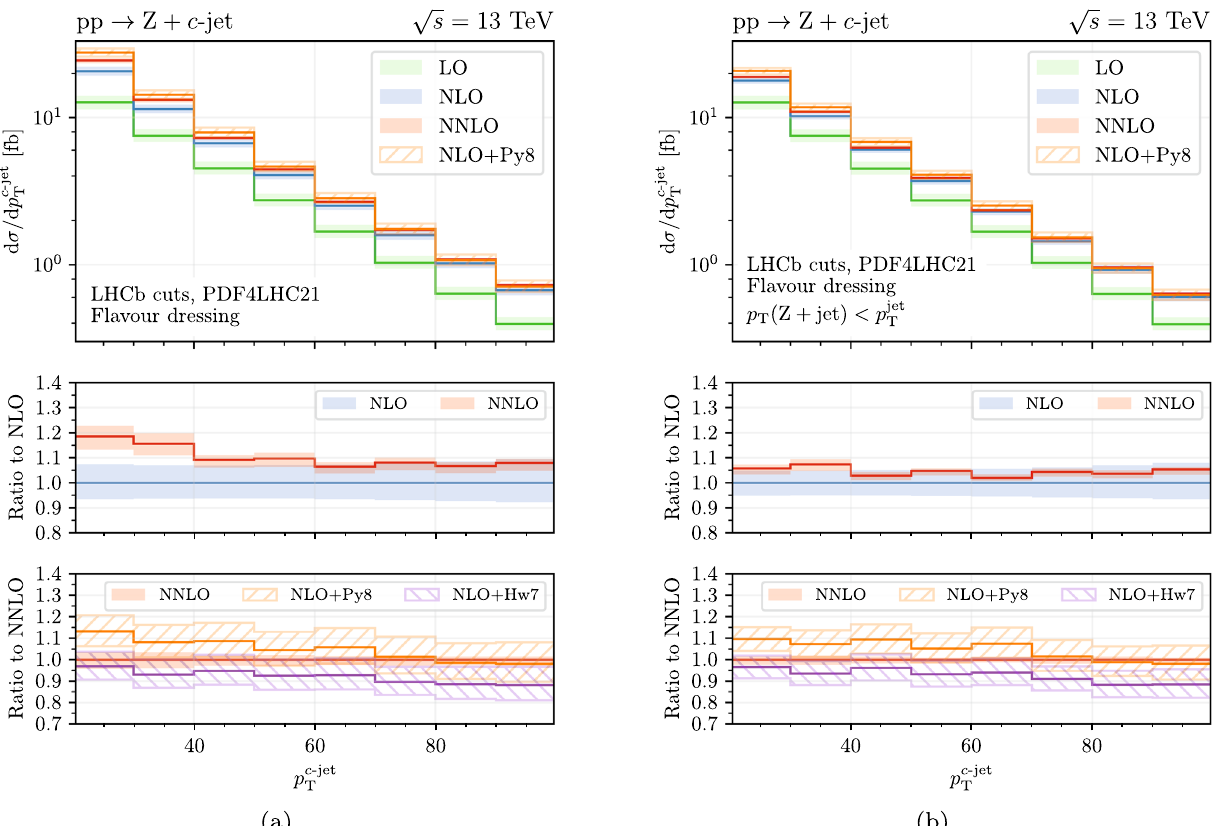
Fig. 1 Comparison of parton-level predictions for the leading NLO+PS predictions with Pythia8 (orange) or Herwig7 (purple) as parton showers. A dynamical cut on the transverse momentum of the flavoured jet transverse momentum p c -jet in the Z + c -jet process: T Z + jet system is further applied in fixed-order predictions at LO (green), NLO (blue) and NNLO (red);